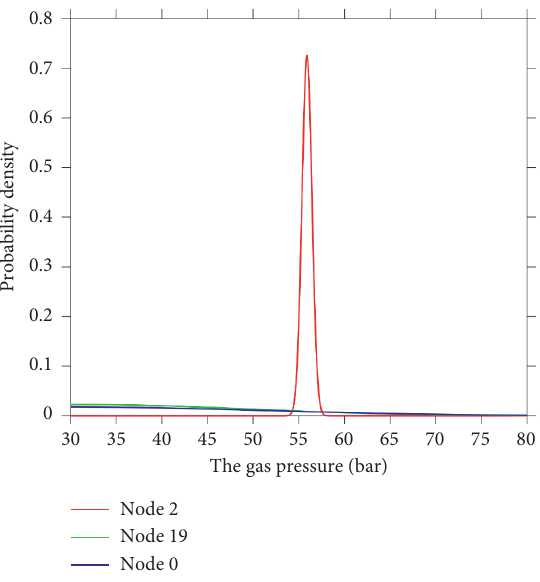
Figure 9: Comparison among Nodes 3, 19, and